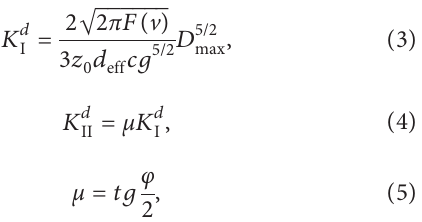
Figure 7: Curves of crack deflection angle with vertical